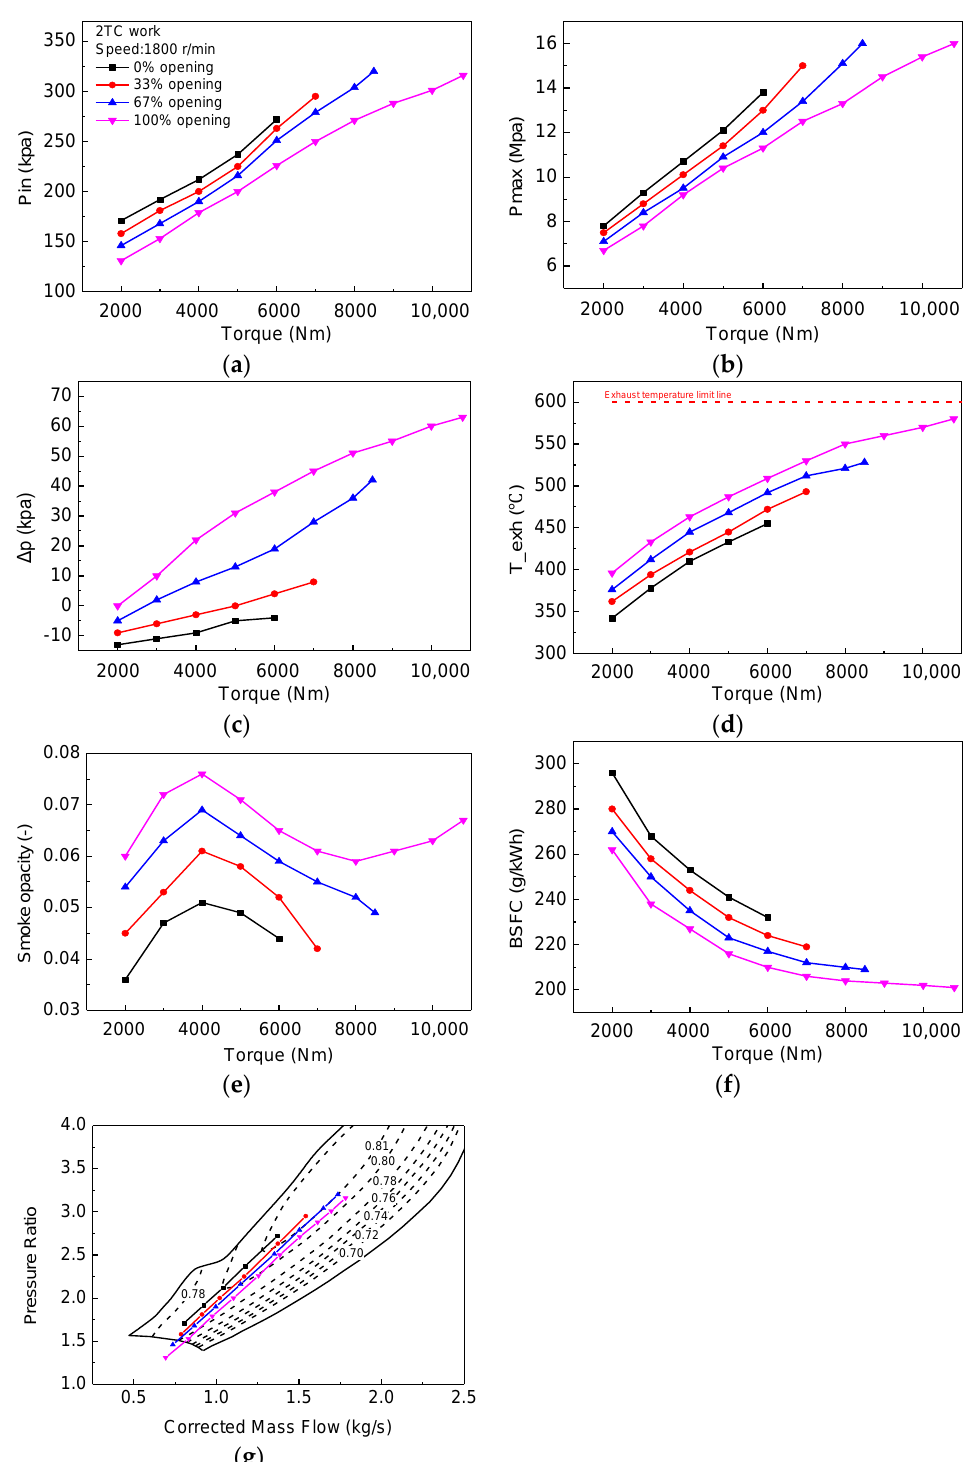
Figure 3. Variations of the main engine parameters at 1429 r/min with the 2TC. ( a ) intake pressure. ( b ) the maximum combustion pressure. ( c ) difference between the intake and exhaust pressures. ( d ) exhaust temperature. ( e ) smoke opacity. ( f ) brake specific fuel consumption. ( g ) compressor.